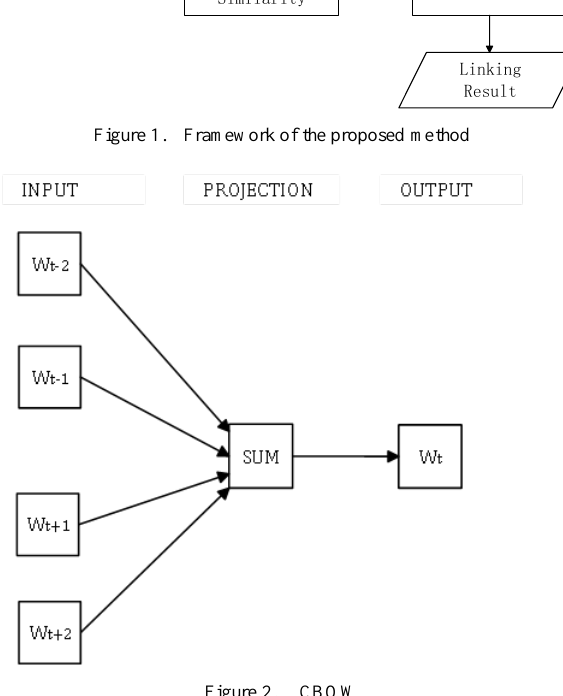
Figure 1. Framework of the proposed method